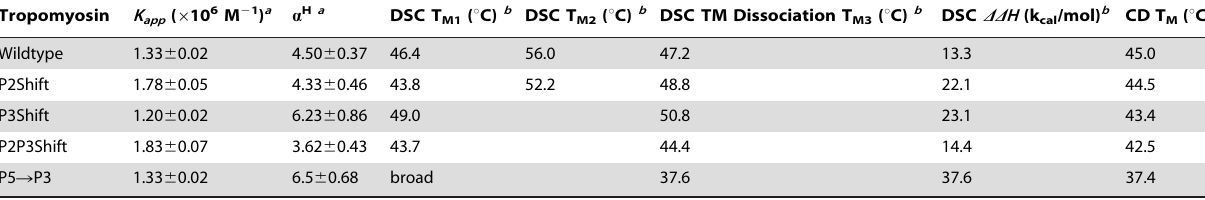
Table 2. The actin affinity and T M from the ellipticity at 222 nm and DSC melts.